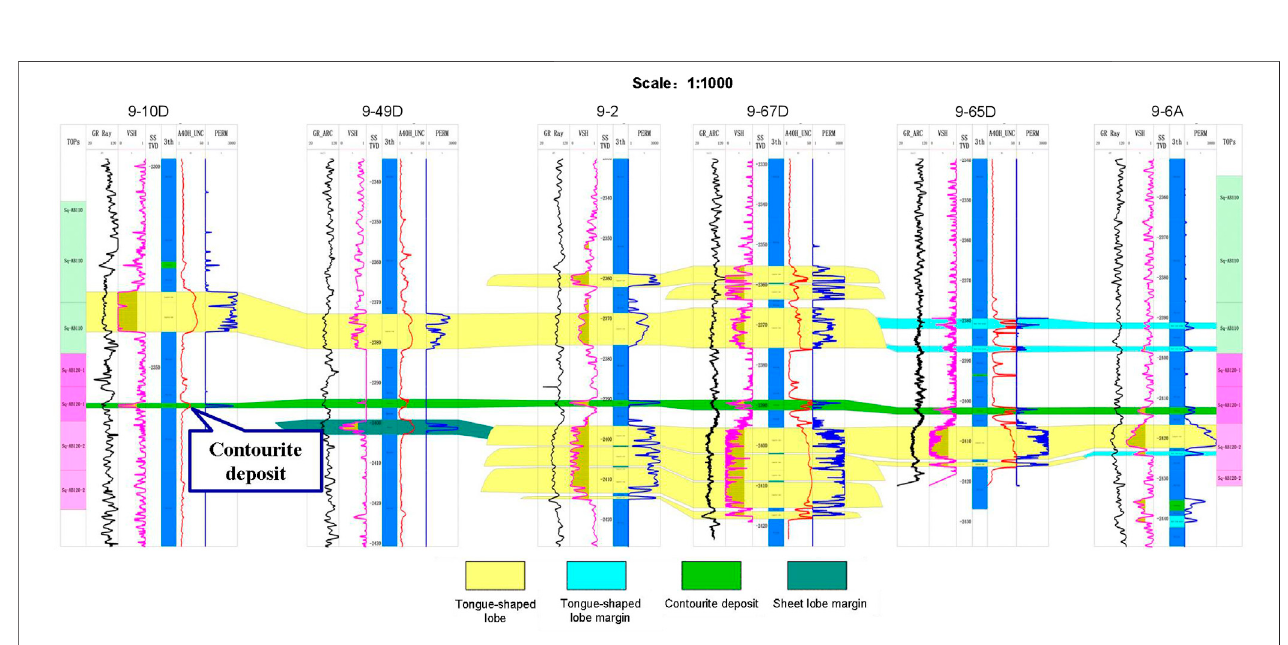
FIGURE 5 | Contourite deposits at the top of the AB120 reservoir.